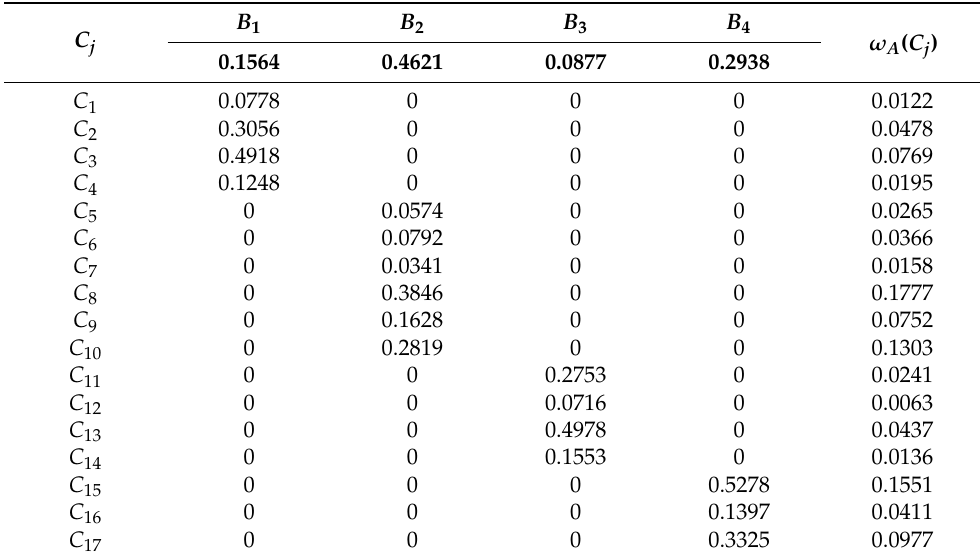
Table 6. Total ranking results of each risk index